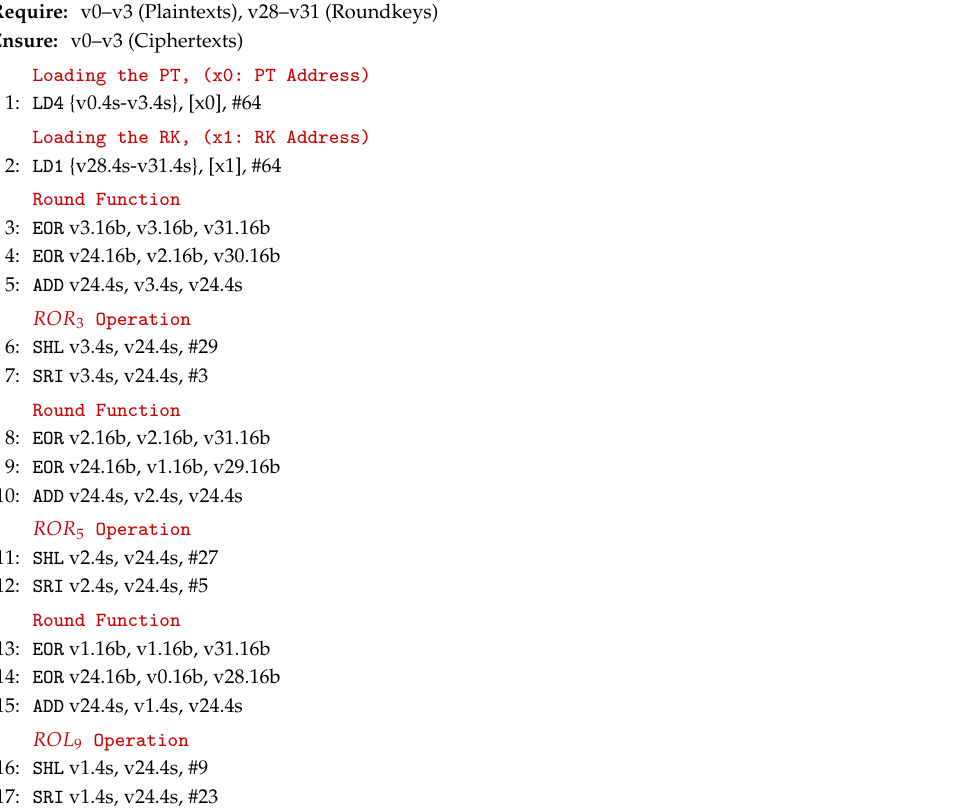
Algorithm 1 Data parallel implementation of LEA-128 Round